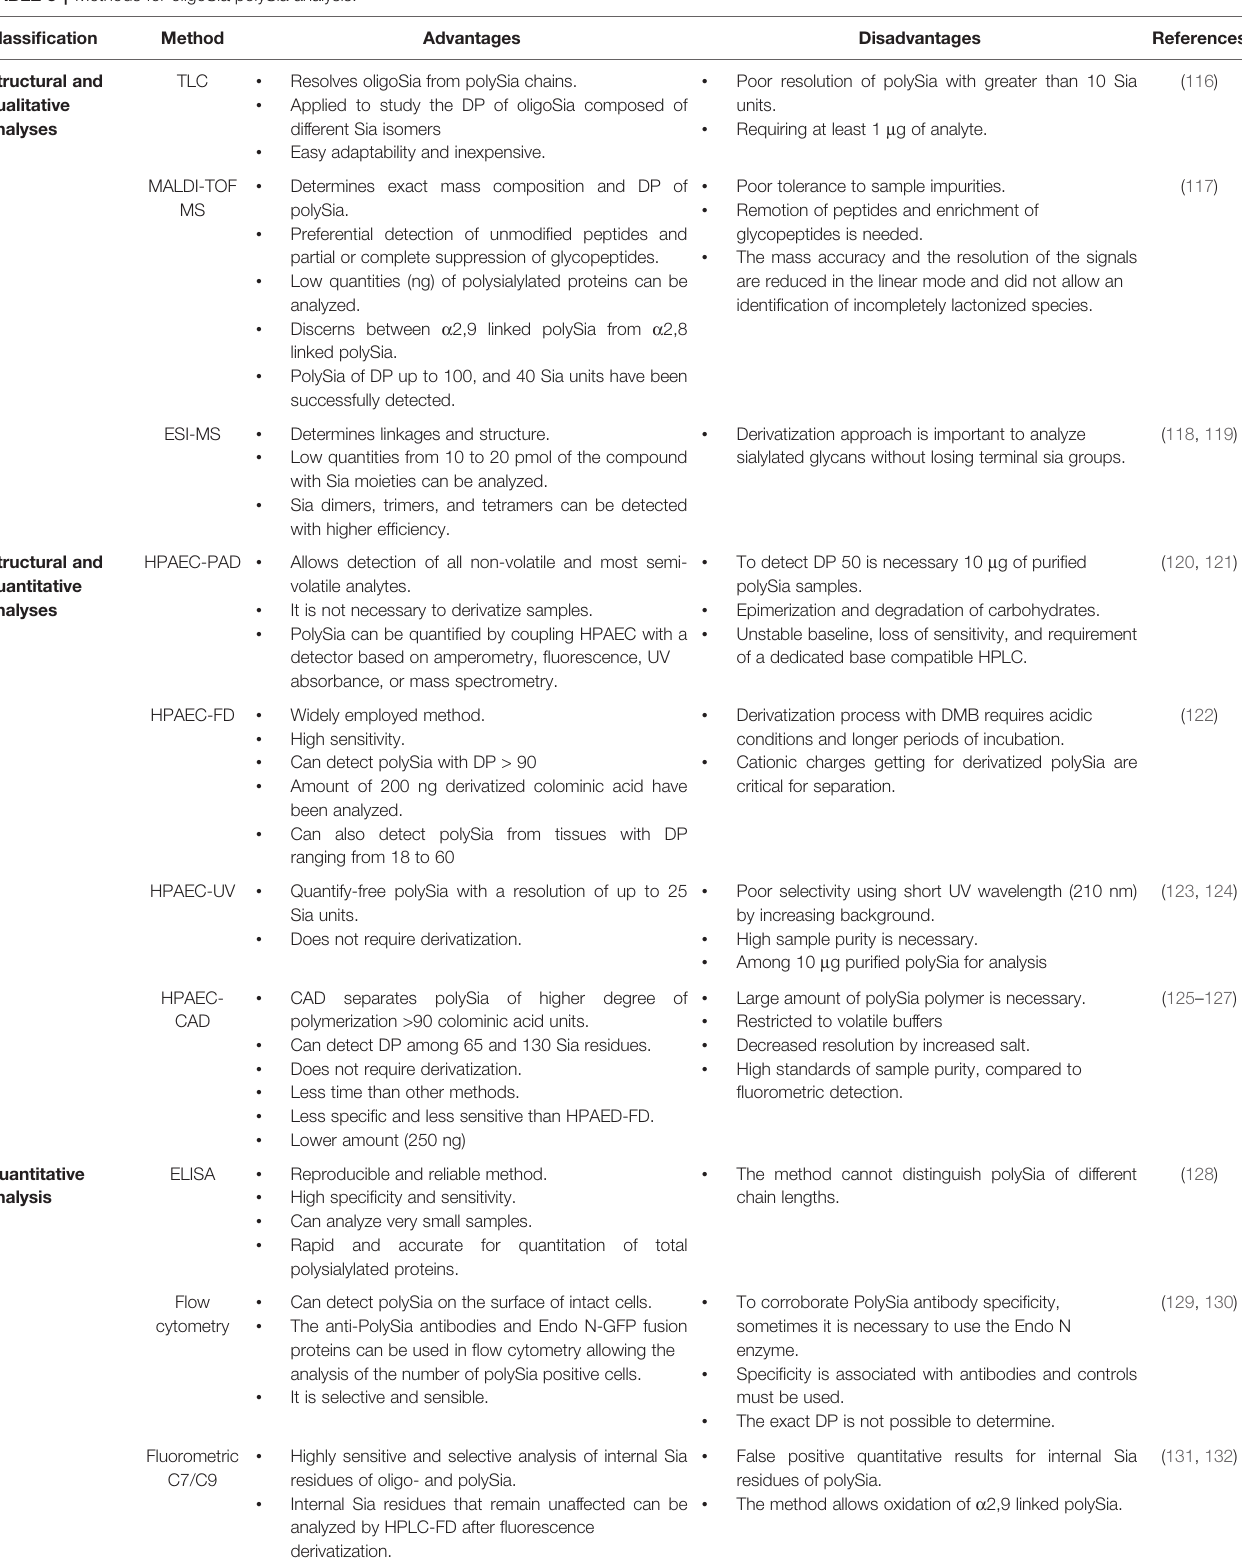
TABLE 3 | Methods for oligoSia/polySia analysis. Classi fi